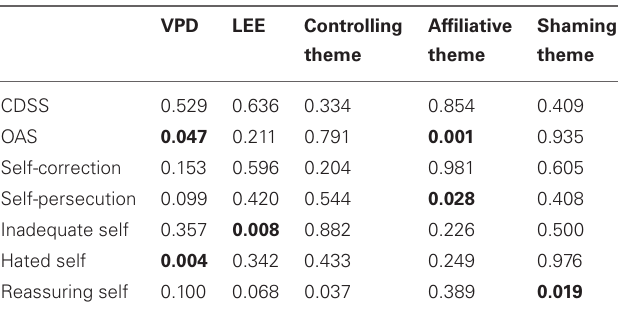
Table 3 | Results of logistic regression analysis examining voice power, expressed emotion, and thematic content of voices and their association with self-critical thinking and self-reassuring